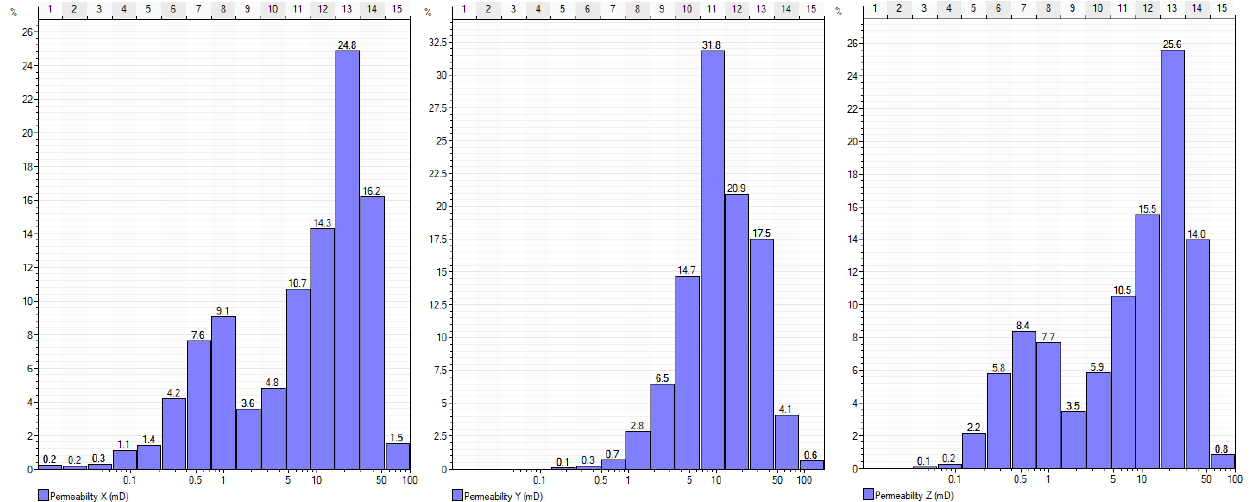
Figure 8. Permeability distribution in the SRV along the hydraulic fracture planes [2].